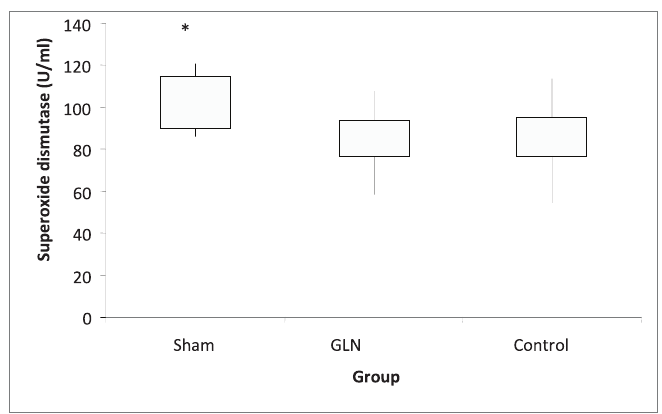
FIGURE 4 - Serum superoxide dismutase in the three groups.* p <0.05 vs GLN and control